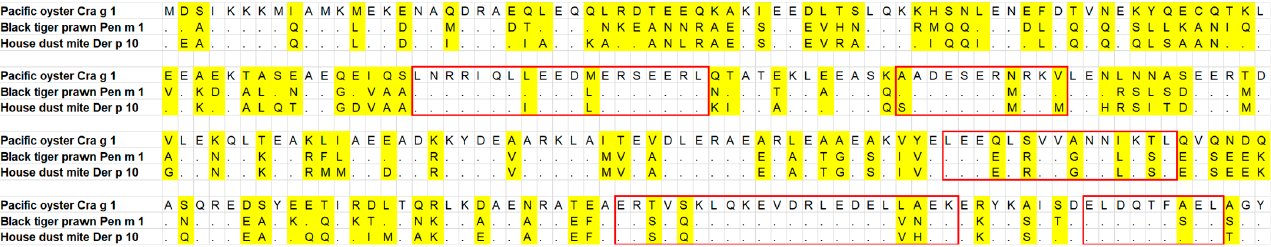
Figure 8. Amino acid sequence alignment of tropomyosin sequence from Pacific oyster ( Crassostrea gigas ), Black tiger prawn ( Penaeus monodon ) and house dust mite ( Dermatophagoides pteronyssinus ). Variable amino acids are shaded in yellow. The predicted IgE-binding epitopes responsible for cross-reactivity in those three species are identified by solid red boxes.